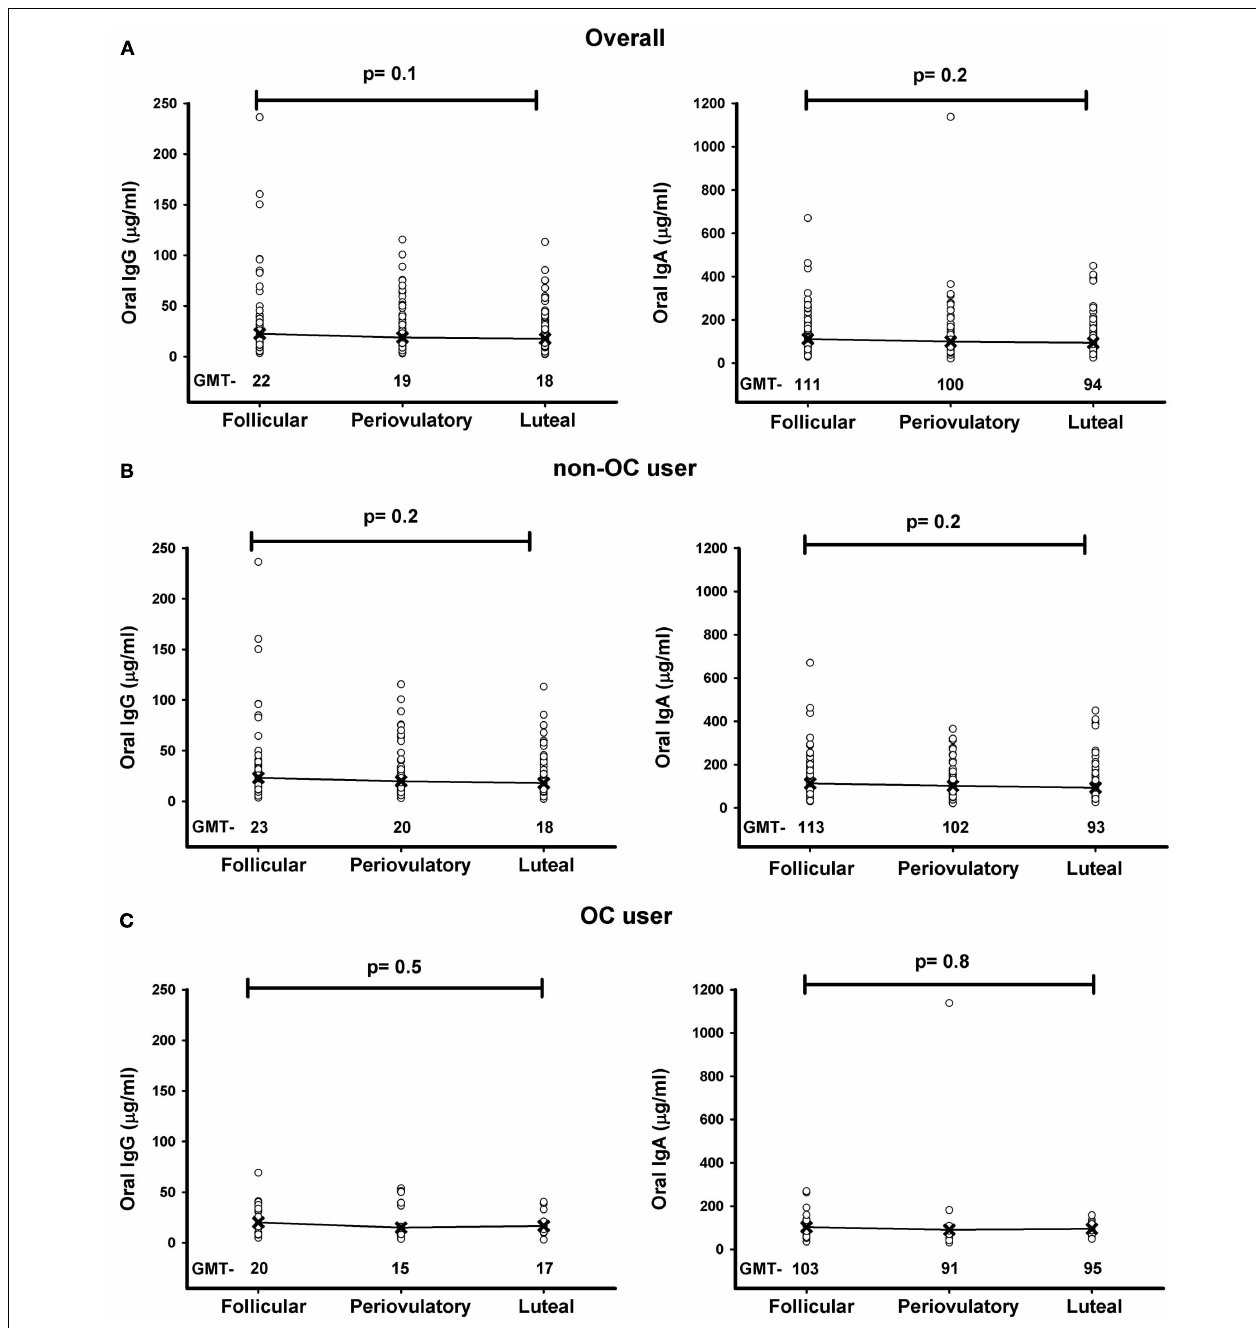
and IgA presented in the graphs is based on untransformed values.The p -value is calculated based on Kruskal–Wallis test, and a p -value < 0.05 is considered significant. GMT, Geometric mean ( µ